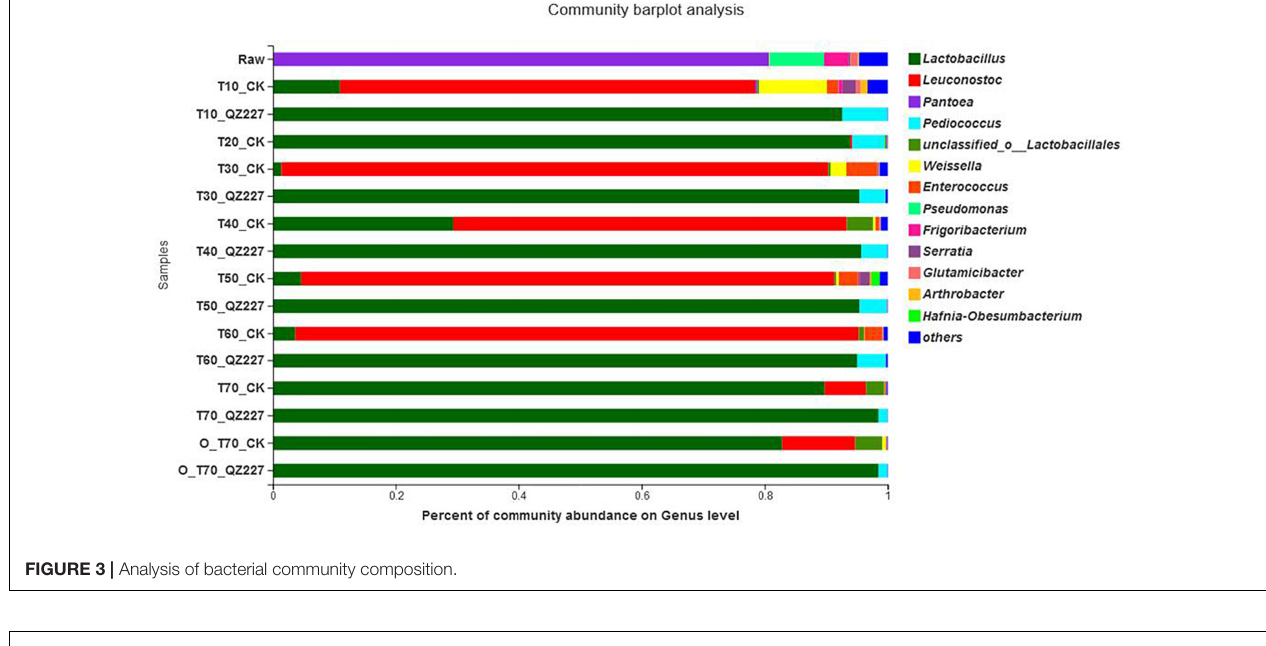
FIGURE 3 | Analysis of bacterial community composition.